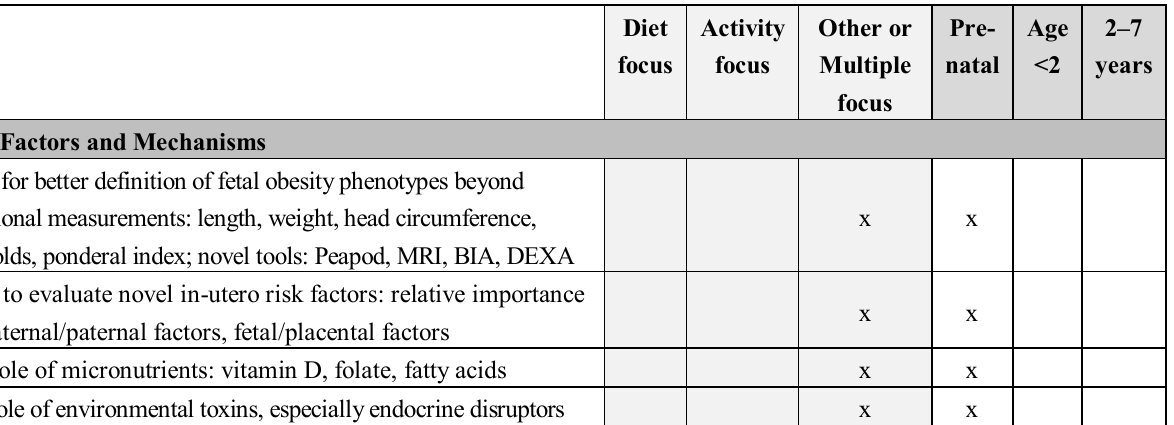
Table 1. Prioritized topics for future